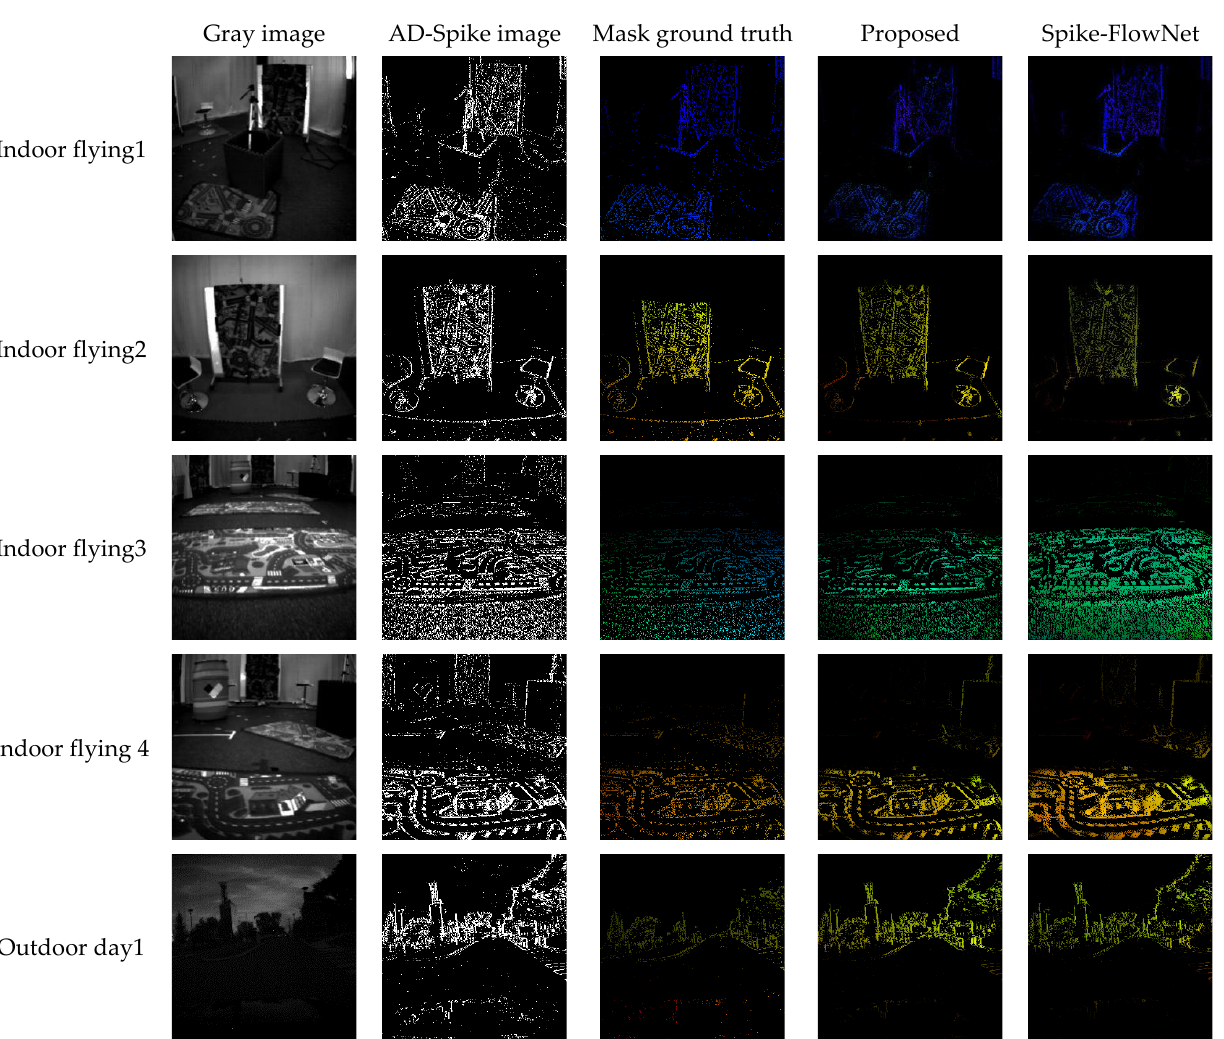
Figure 7. Optical flow comparison with Spike-FlowNet. From left to right: Grayscale image, spike image, masked ground truth, our masked predicted optical flow, and spike-FlowNet’s optical flow, where the images are taken from indoor flying1, indoor flying2, indoor flying3, and outdoor day1, respectively.